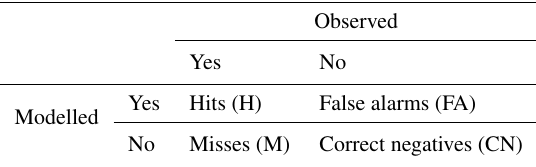
Table 3. Contingency table for flood